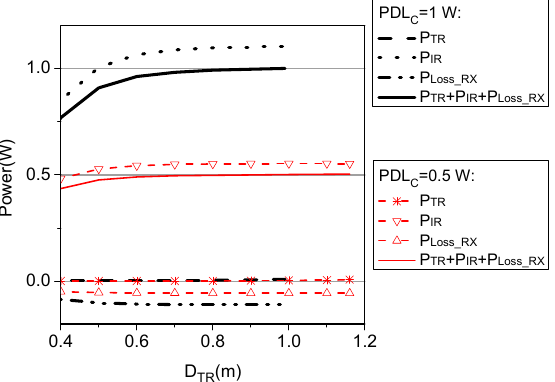
Figure 15. Power delivered to RX and power loss in it at 1.96 MHz under considering cross coupling model when PDL C = 1 W and 0.5 W.